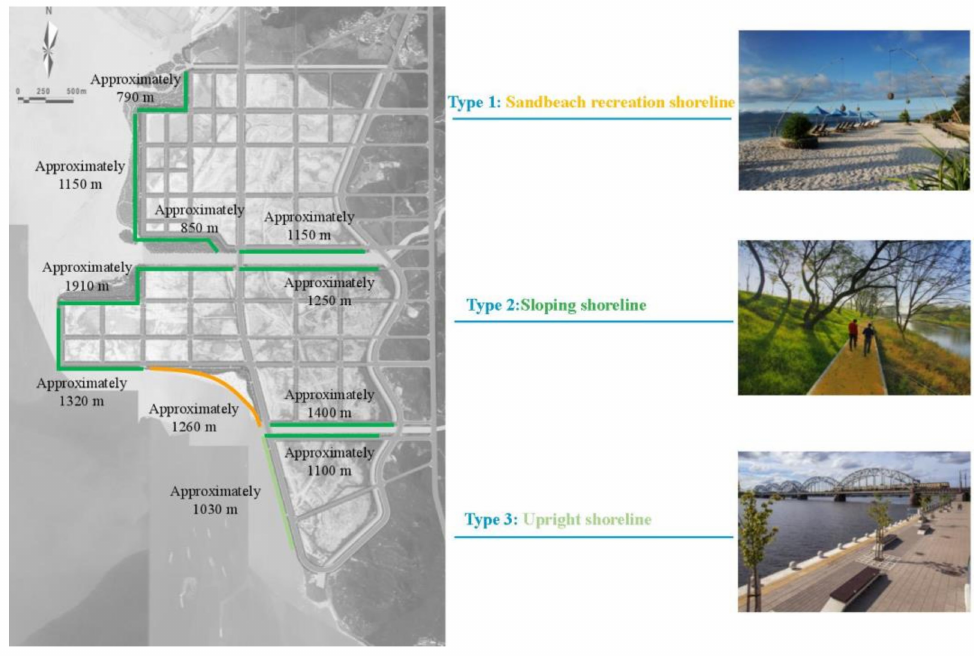
Figure 7. The ecological-shoreline-repair